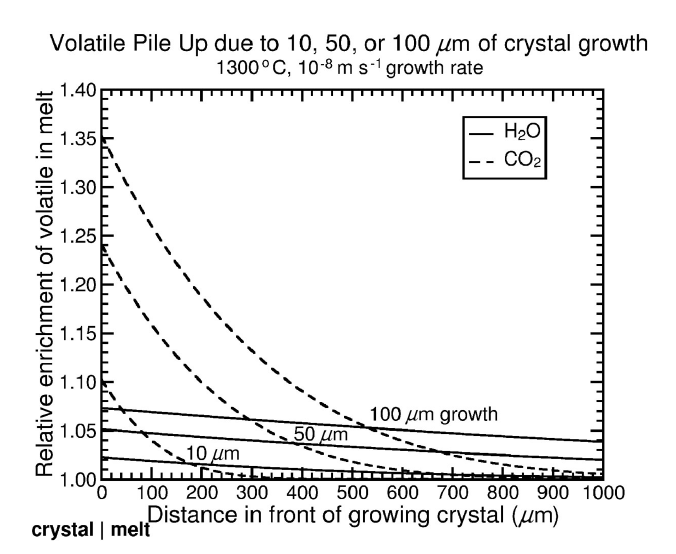
Fig. 8. Volatile concentration enrichment profiles in front of a crystal growing in a basaltic melt at 1300°C. Dif- fusion coefficients of H 2 O and CO 2 are from Zhang and Stolper (1991) and crystal growth rates are based on da- ta in Lasaga (1998) and Simakin et al . (2003). For further discussion please see the